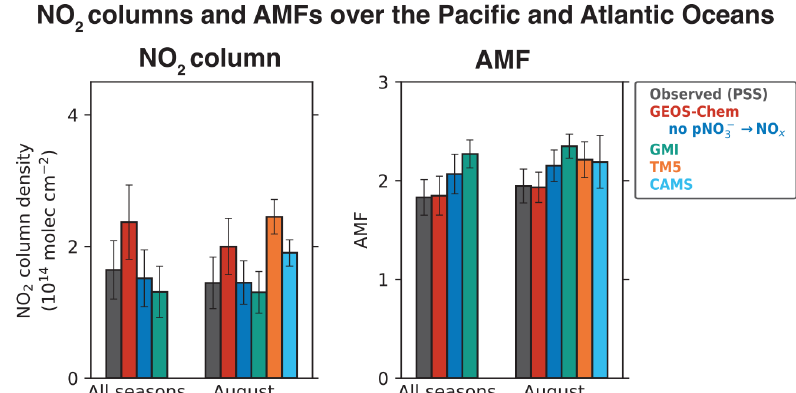
Figure 6. Tropospheric NO 2 column densities and NO 2 air mass factors (AMFs) over the Pacific and Atlantic oceans during ATom. The observed values are based on the median NO 2 vertical profiles calculated using the photochemical steady state (PSS) with local measurements of NO concentrations and other quantities following Eqs. (2) and (3). Model results are from our baseline GEOS-Chem simulation, GEOS- Chem simulation without p NO − photolysis, and GMI, TM5, and CAMS sampled along the flight tracks. Values shown are medians for 3 all four ATom deployments and for the August deployment, as the TM5 and CAMS NO 2 profiles are available only for August. AMFs are calculated using the NASA OMI NO 2 v4.0 scattering weights, following Eq. (6), with geometric AMF (AMF G ) values of 2.6 for 30 ◦ S–30 ◦ N and 3.7 for 30–60 ◦ S and 30–60 ◦ N. Error bars show the standard deviations of the medians and are calculated using jackknife